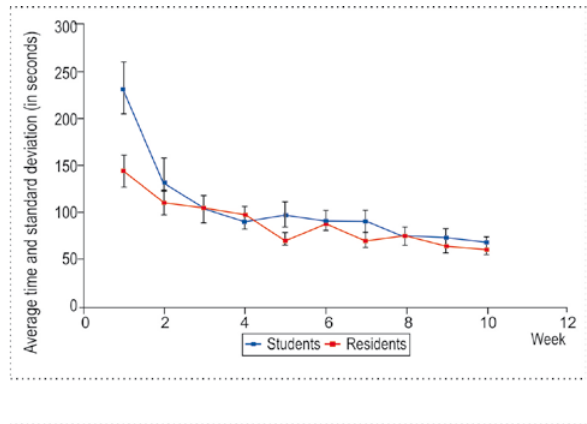
Figure 1 – Learning curves of time on clipping skill, for all three